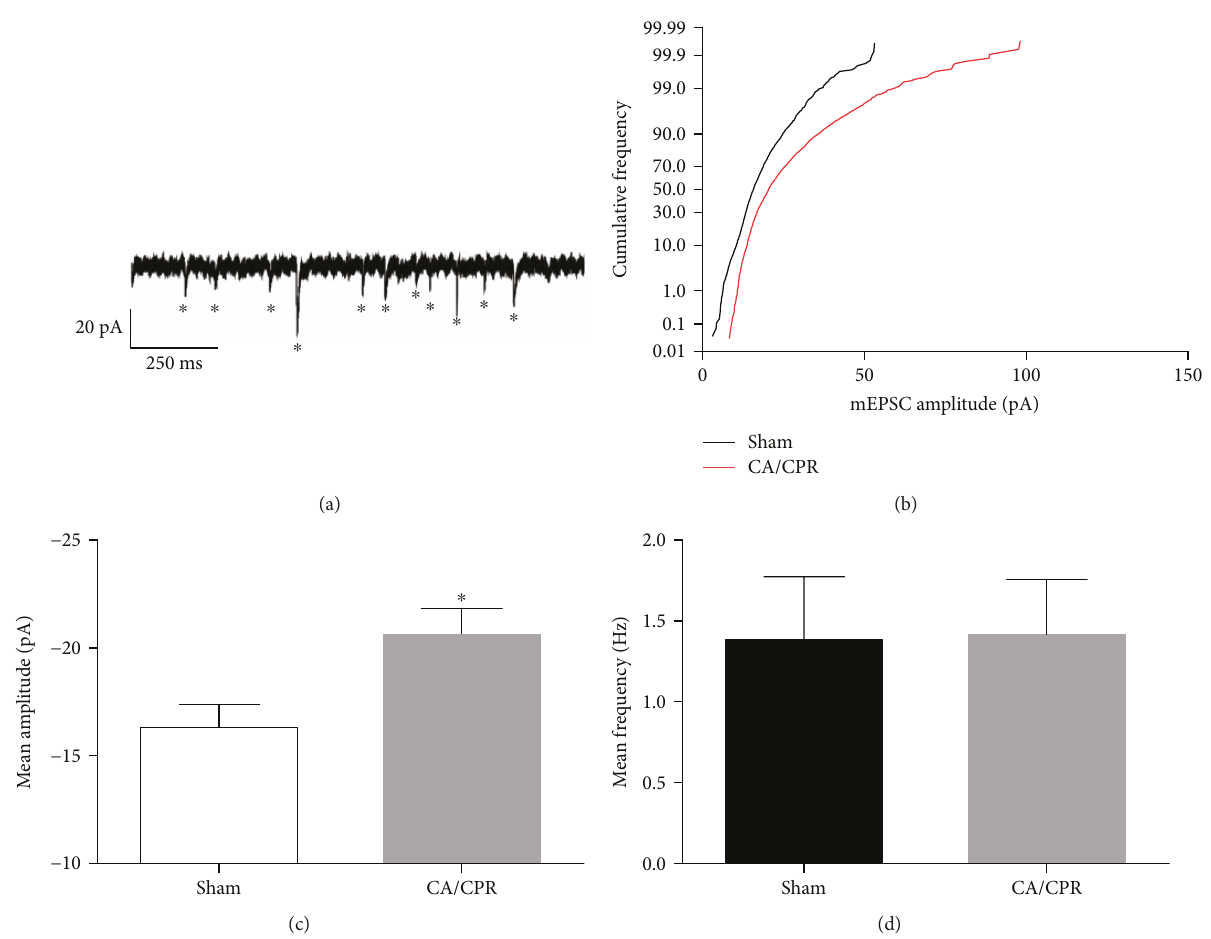
Figure 1: Lasting potentiation of miniature excitatory postsynaptic currents (mEPSCs) induced by cardiac arrest. (a) A representative trace from a sham control of whole-cell voltage clamp recording of mEPSC events recorded from CA1 neurons in acute brain slices. Events were detected with Clamp fi t software and are indicated with an asterisk. (b) CA/CPR produced a rightward shift in the cumulative frequency distribution of mEPSC amplitudes relative to shams. Events from sham (black, n = 2729 events) or CA/CPR (red, n = 3213 events) mice were pooled to generate histograms. (c) CA/CPR produced an increase in mean mEPSC amplitudes compared to sham. Mean mEPSC amplitude was calculated for each recording (sham: n = 12 ; CA/CPR: n = 15 ), and means for groups were compared using Student ’ s unpaired t -test ( ∗ indicates p < 0 05 ). (d) CA/CPR did not alter synaptic density in CA1 neurons. No change in mean mEPSC frequency was observed between sham and CA/CPR mice. Mean mEPSC frequency was calculated for each recording (sham: n = 12 ; CA/CPR: n = 15 ), and means for groups were compared using Student ’ s unpaired t -test.